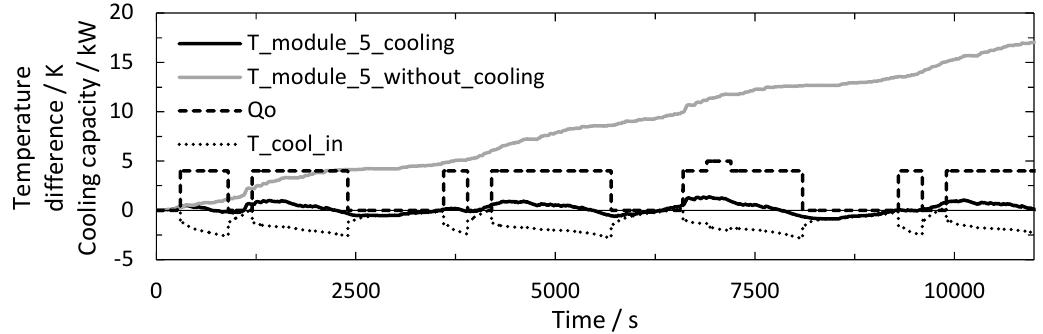
Figure 15. Coolant temperature, coolant capacity, controlled and uncontrolled mean battery cell temperature of module 5 for two times line 92. The temperature difference refers to the initial conditions.